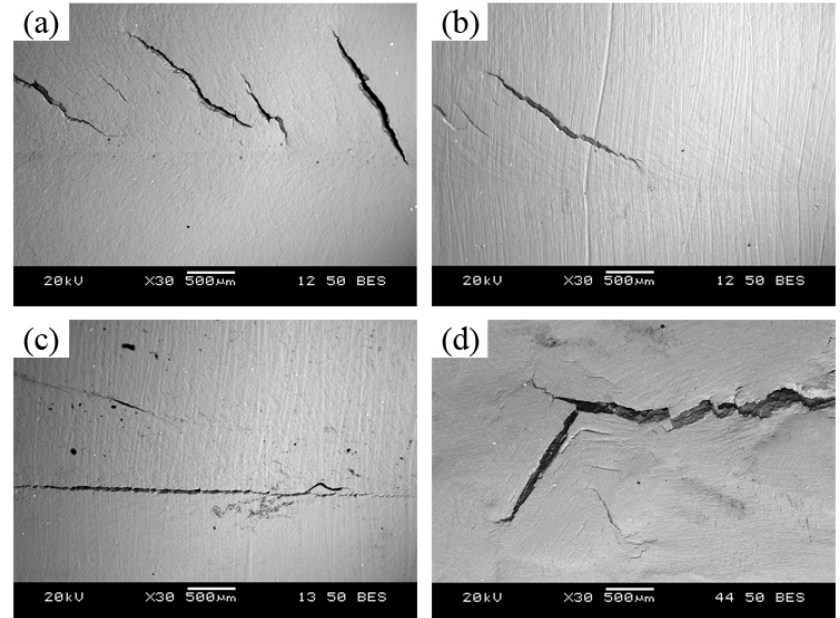
Figure 5. Crack propagation of M-FSP plates after Erichsen cupping tests at different punching speeds of ( a ) 0.1 mm/min; ( b ) 1 mm/min; ( c ) 10 mm/min; and ( d ) BM tested at 1